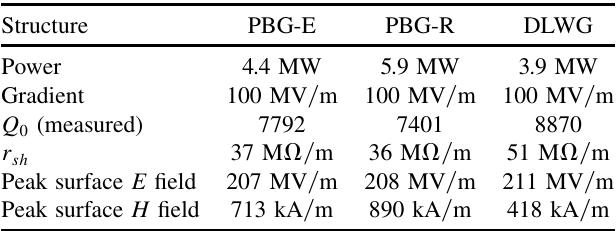
TABLE III. Surface field values from HFSS simulations for PBG-E structure, PBG-R structure, and disk-loaded waveguide structure. The shunt impedance calculated here is for a periodic (cid:4) mode structure; i.e., a structure composed of iterations of the central cell of the three-cell structures